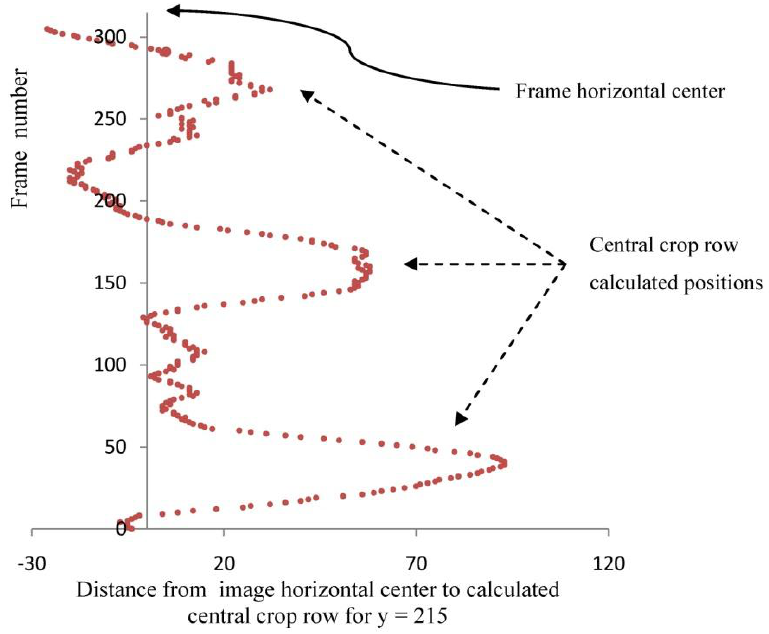
Figure 5. Graphical representation of the measured distance between the horizontal frame center and the calculated position of the central crop row in the lower part of the frame (y = 215) for the 306 test